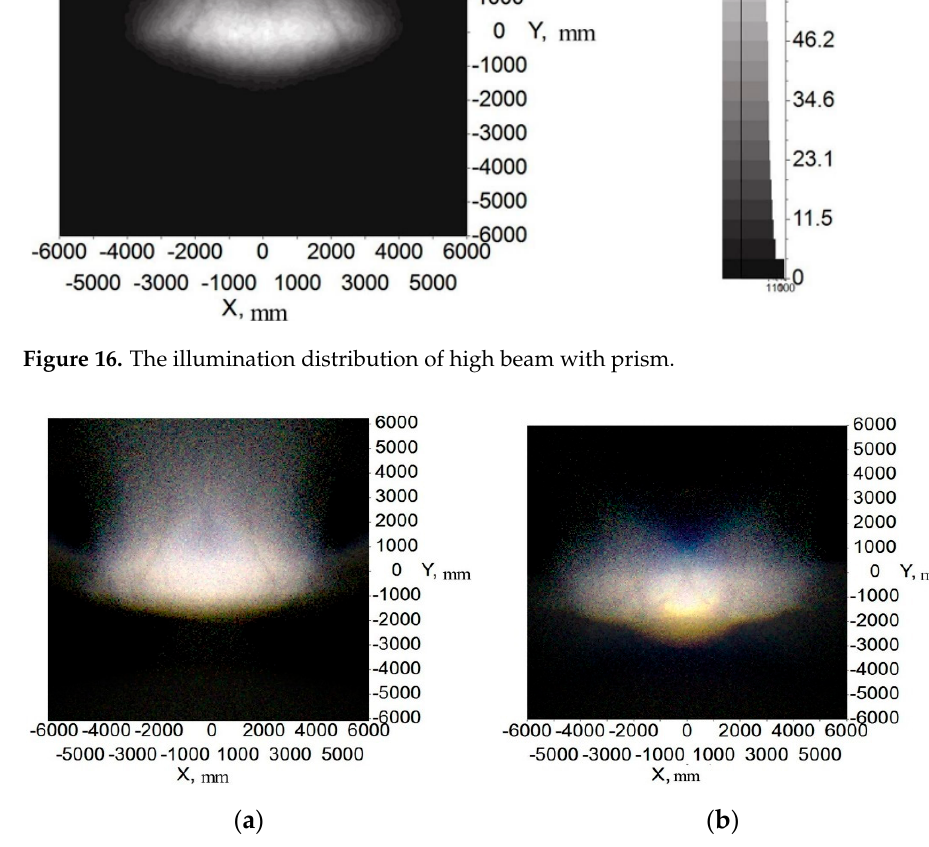
Figure 17. ( a ) The color distribution of high beam with a prism and ( b ) without a prism. Table 1. Simulated illuminance values of low beam on the target